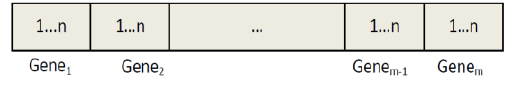
and each gene has a value between 1 to n.